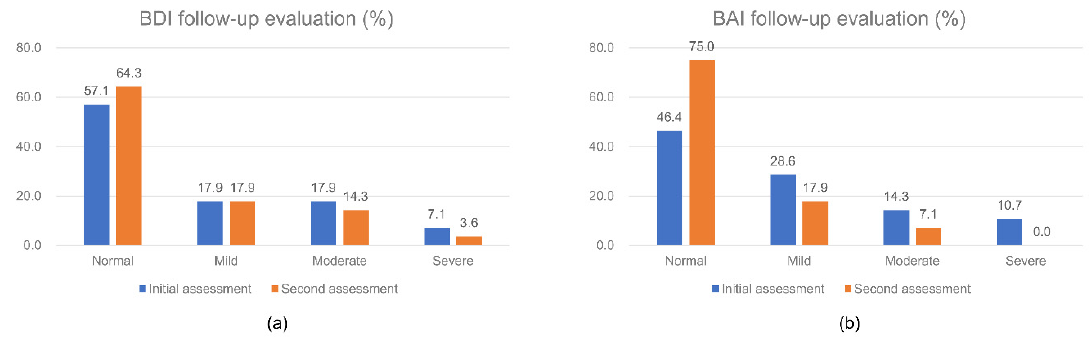
Figure 1. Follow-up evaluations of mood using ( a ) Beck depression inventory (BDI), and ( b ) Beck anxiety inventory (BAI).